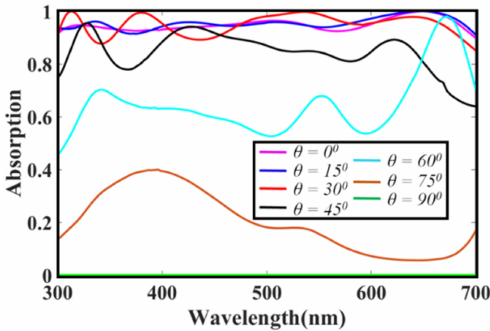
Figure 8. Absorption spectra for di ff erent incidence